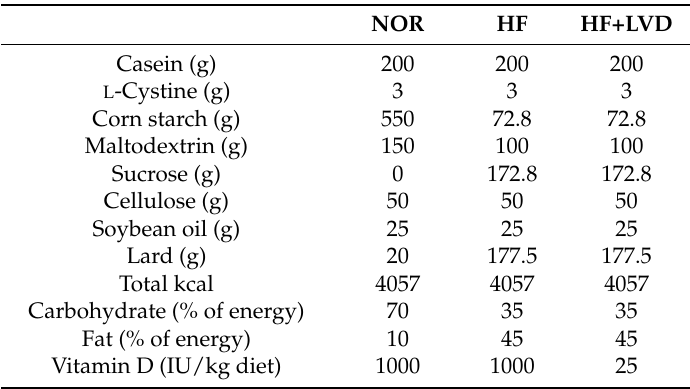
Table 1. Content of intervention